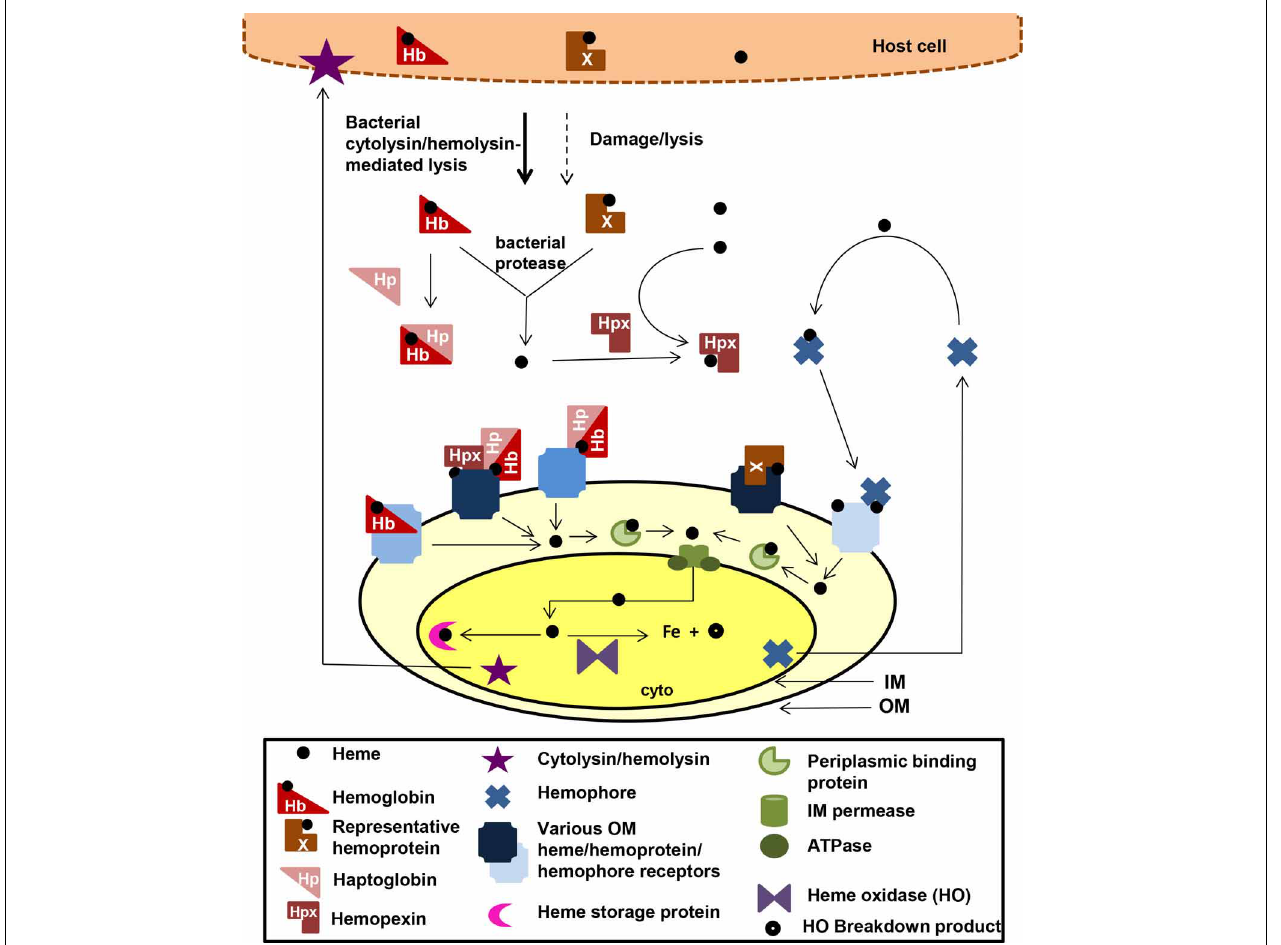
FIGURE 1 | Mechanisms for heme iron acquisition from the host by gram-negative bacteria. Bacteria factors damage host cells releasing heme, Hb, and other hemoproteins. Additionally, secreted bacterial hemophores capture host heme. Extracellular host Hb and heme may be bound by host Hp and Hpx, respectively. A bacterium could acquire iron from these host heme sources using one or more TonB-dependent outer membrane (OM) receptors for these heme compounds, which transport the heme through the outer membrane into the periplasm. Some OM receptors are specific for one